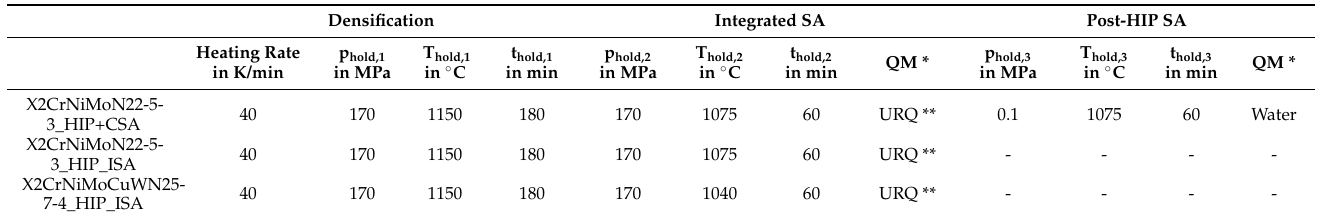
Table 2. Parameters used for the densification and solution annealing of the X2CrNiMoN22-5-3 and X2CrNiMoCuWN25-7-4 powder. *Quenching medium.